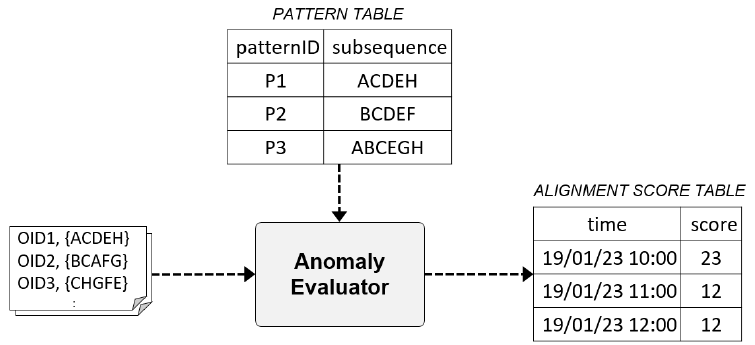
Figure 6. Example of input and output data for the Anomaly Evaluator.